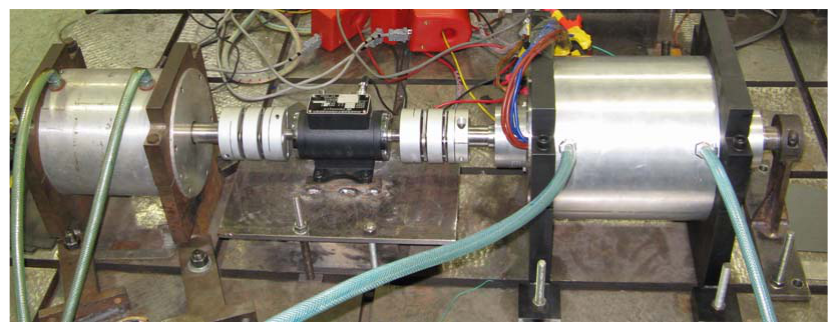
Figure 14. Test bench of the